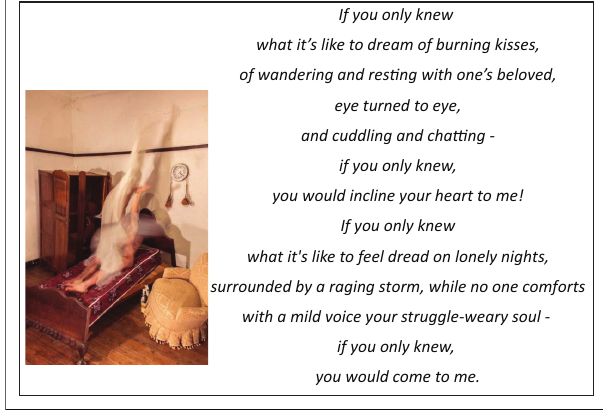
FIGURE 1: Cäcilie : ‘The